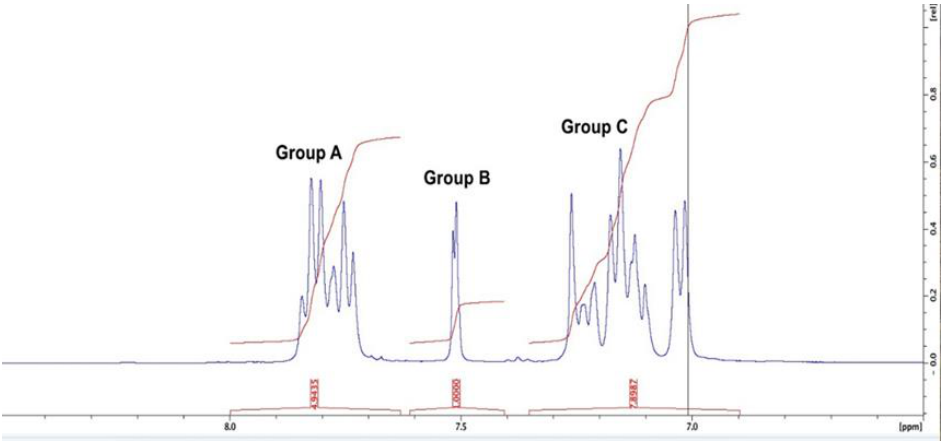
Figure 4. 1 H NMR spectrum of SPEEK in dimethyl sulfoxide .